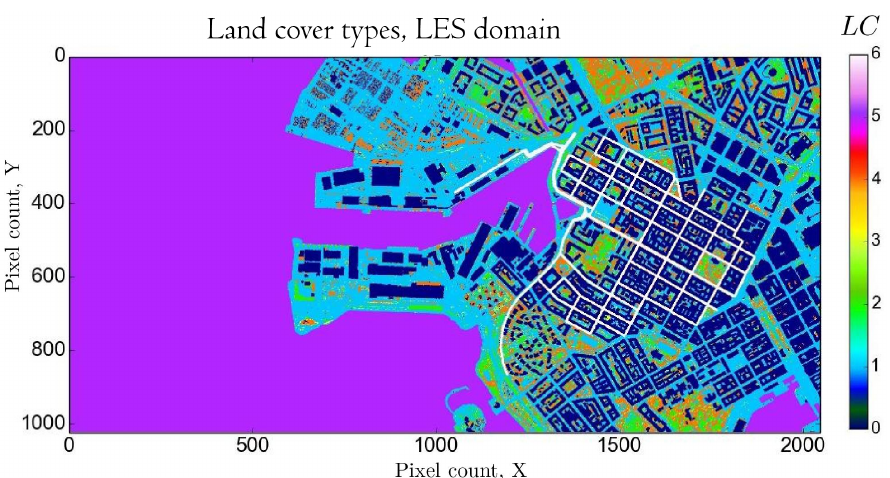
Figure 10. Raster map of land cover types, LC , within the LES domain. The original surface type classification data in Fig. 1 has been augmented by adding streets ( LC = 6) to the relevant footprint area.